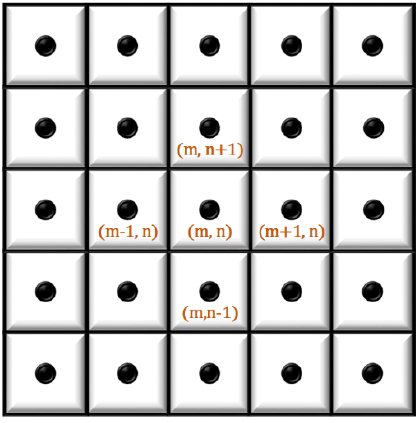
Figure A1. A uniform rectangular grid with voxel (m, n) at its center.